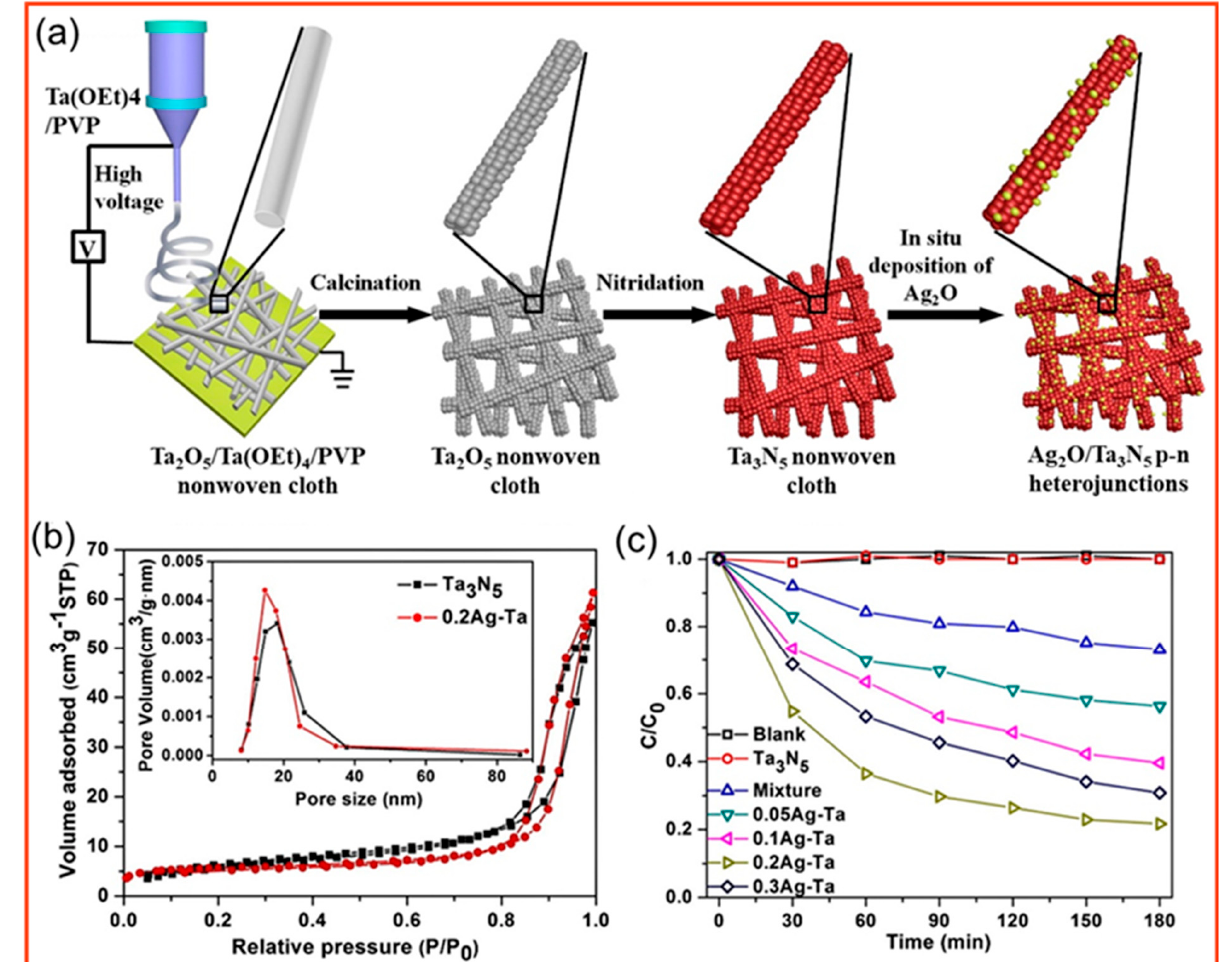
Figure 10. ( a ) Schematic of the synthesis of p − n heterojunction Ag 2 O/Ta 3 N 5 nanofibers; ( b ) N 2 adsorption − desorption isotherms and pore size distribution of pure Ta 3 N 5 and 0.2Ag − Ta (inset); ( c ) degradation efficiency of TC (10 mg·L − 1 , 80 mL) during degradation with different catalysts (60 mg) [147].